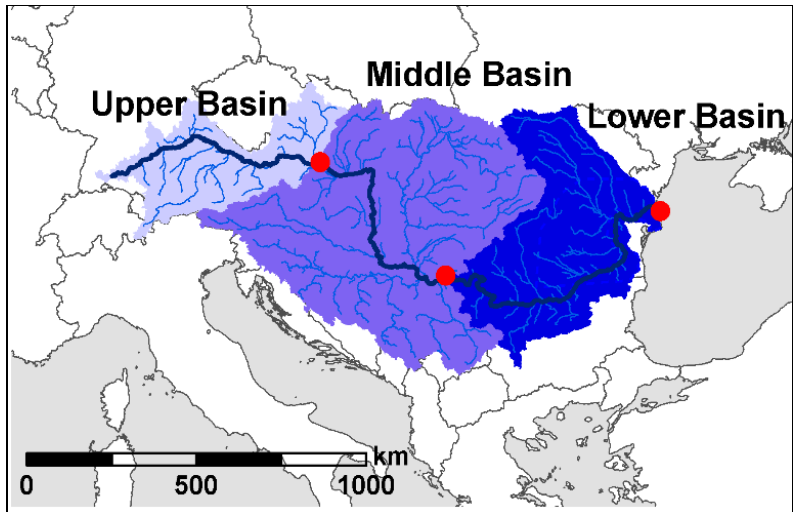
Figure 2. The Danube River catchment divided into the Upper Danube basin (until the Bratislava station), the Middle Danube basin (until the Bazias station) and the Lower Danube basin (until the Ceatal Izmail